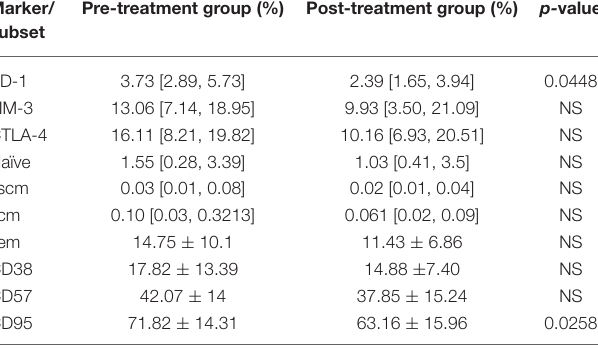
TABLE 5 | The changes of all the marker’s expressions of laboratory evaluations of efficacy. Marker/ Pre-treatment group (%) Post-treatment group (%) p- subset